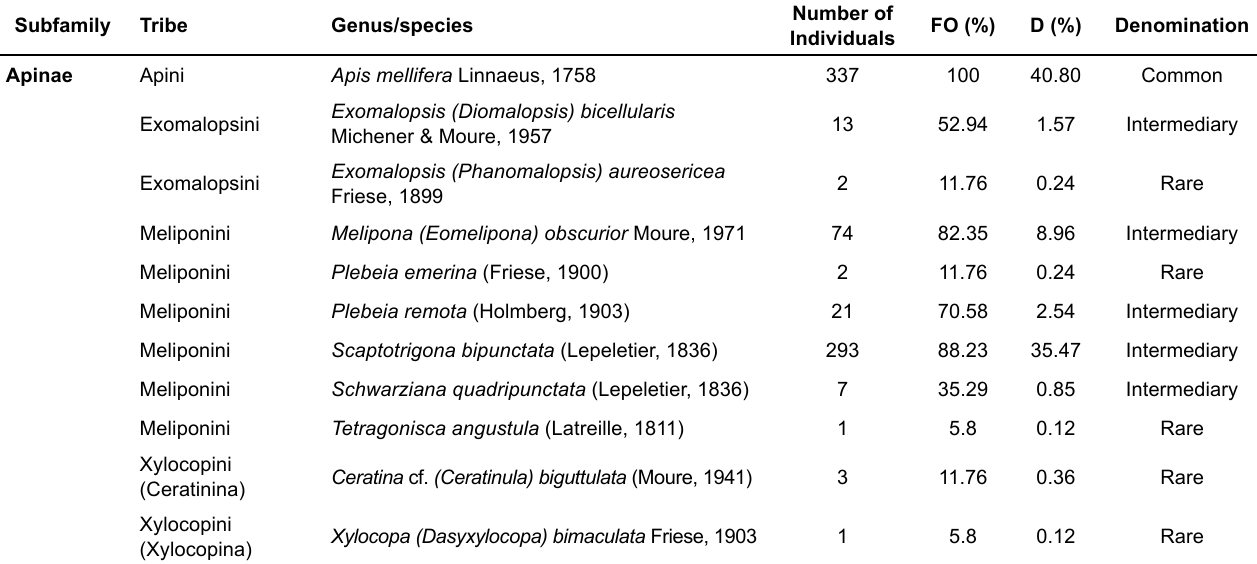
Table 1. Species of flower visiting bees collected on Eugenia uniflora L. in fragments of mixed ombrophilous forest (Atlantic Forest) in south Brazil. Indices of frequency of occurrence (FO), dominance (D) and the denomination for each species of floral visitor bee. (Continuation) Subfamily